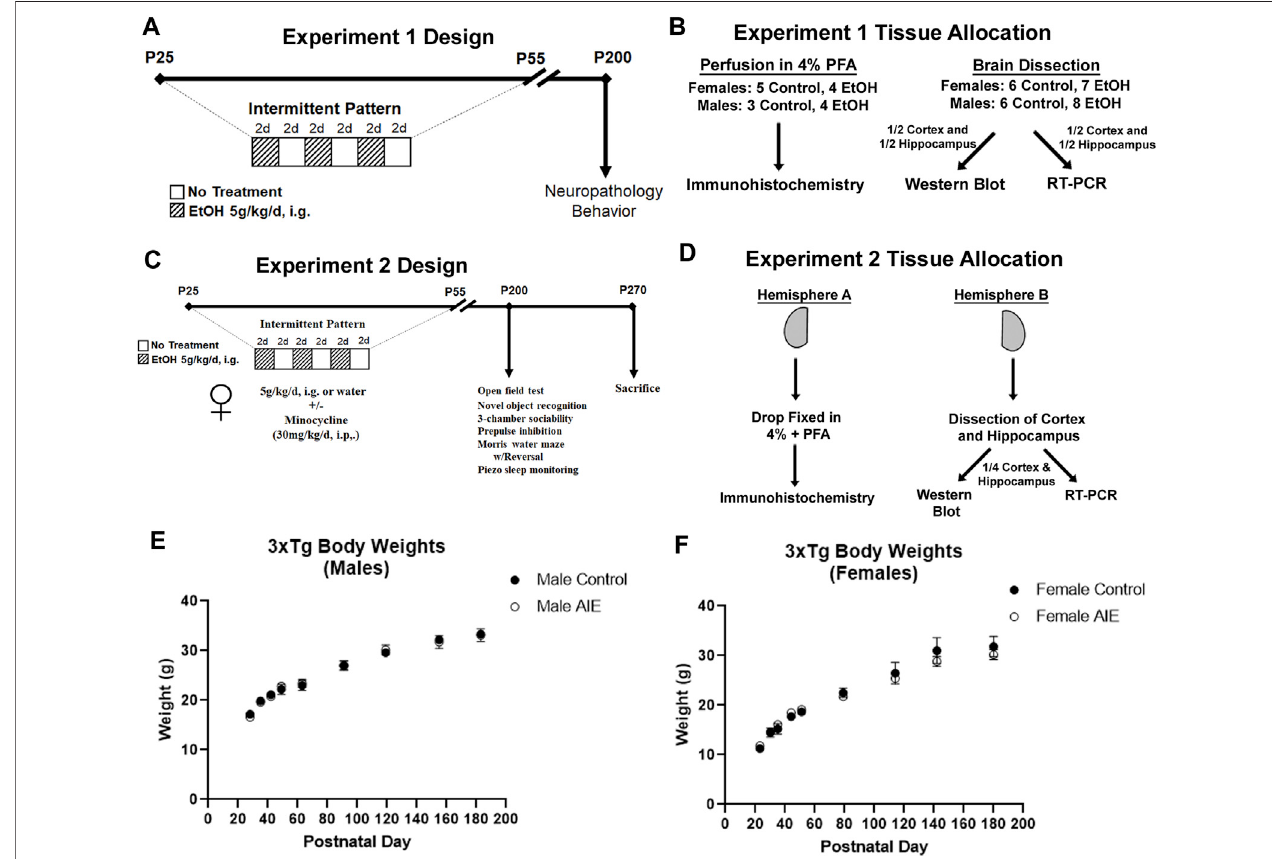
FIGURE 1 | Experimental design and tissue allocation for both experiments. (A, B) Experiment 1. (A) Adolescent 3xTg male and female mice received either water gavage (i.g.) or AIE (5 g/kg/d, i.g.) from P25-55, in a 2-days on 2 days off pattern. Mice were then left without intervention until P200. (B) 16 mice were sacri fi ced by cardiac perfusion with 4% PFA for immunohistochemistry (Females: N = 5 control, 4 ethanol; Males: N = 3 control, 4 ethanol), with remaining mice perfused with PBS (Females: N = 6 control, 8 ethanol; Males: N = 6 control, 8 ethanol) and the cortex and hippocampus dissected and frozen in liquid nitrogen. One half of the cortex andhippocampuswerepreparedforwesternblot,whiletheotherhalveswerepreparedforRT-PCR. (C,D) Experiment2. (C) Femalemicereceivedeitherwatergavage +vehicle(i.p.)( N =5),minocycline(Min,30 mg/kg,i.p., N =5),AIE( N =9),orAIE+Min( N =8)inthesamescheduleasExperiment1,withbehavioraltestingbeginningat P200. Mice were sacri fi ced at the end of the behavioral testing on P270. (D) Mice were sacri fi ced by cardiac perfusion with PBS and one hemisphere was drop- fi xed in PFA for IHC and the other hemisphere dissected for cortex and hippocampus. Dissected cortex and hippocampus from one hemisphere were divided equally for western blot and RT-PCR analyses. (E) Body weights of male subjects across treatment and maturation into adulthood. (F) Body weights of female subjects across treatment and maturation into adulthood.